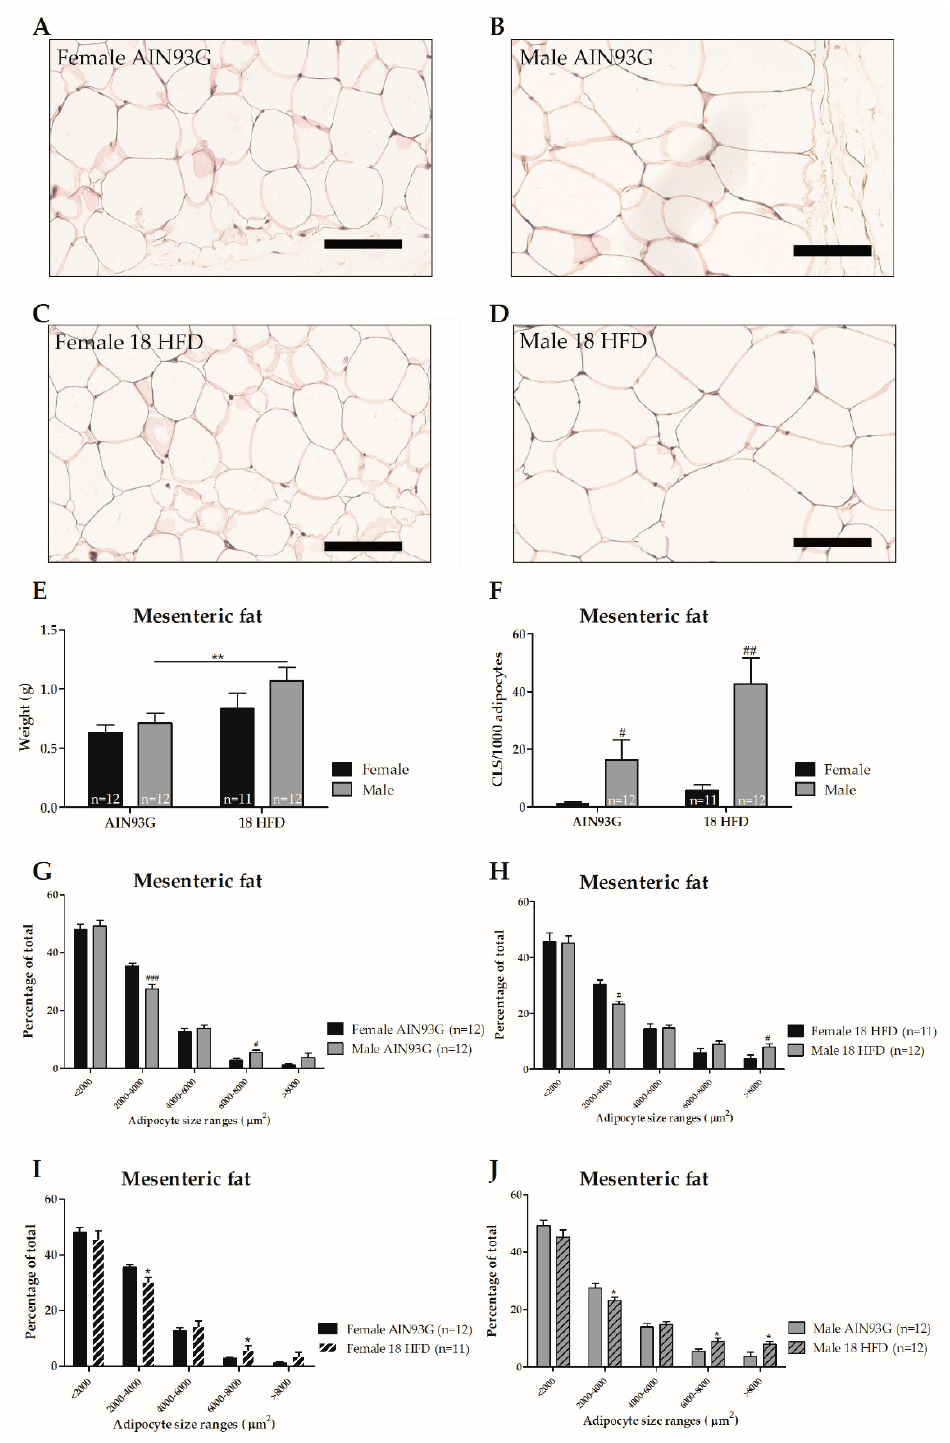
Figure 4. Adipose tissue analysis in Ldlr-/-.Leiden mice after 18 weeks of AIN93G diet or HFD feeding. Representative photomicrographs of haematoxylin phloxine and saffron (HPS) stained mesenteric adipose tissue per experimental group ( A – D ). Scale bar is 100 µm. Analyses of weight ( E ) and level of inflammation as indicated by crown-like structures (CLS) per 1000 adipocytes ( F ) in the mesenteric fat depot. Distribution of adipocyte sizes for either AIN93G diet ( G ), HFD diet ( H ) or sex: female ( I ) and male ( J ). Significant dietary effects * p ≤ 0.050 and ** p ≤ 0.010. Significant effects in sex # p ≤ 0.050 and ### p ≤ 0.001.